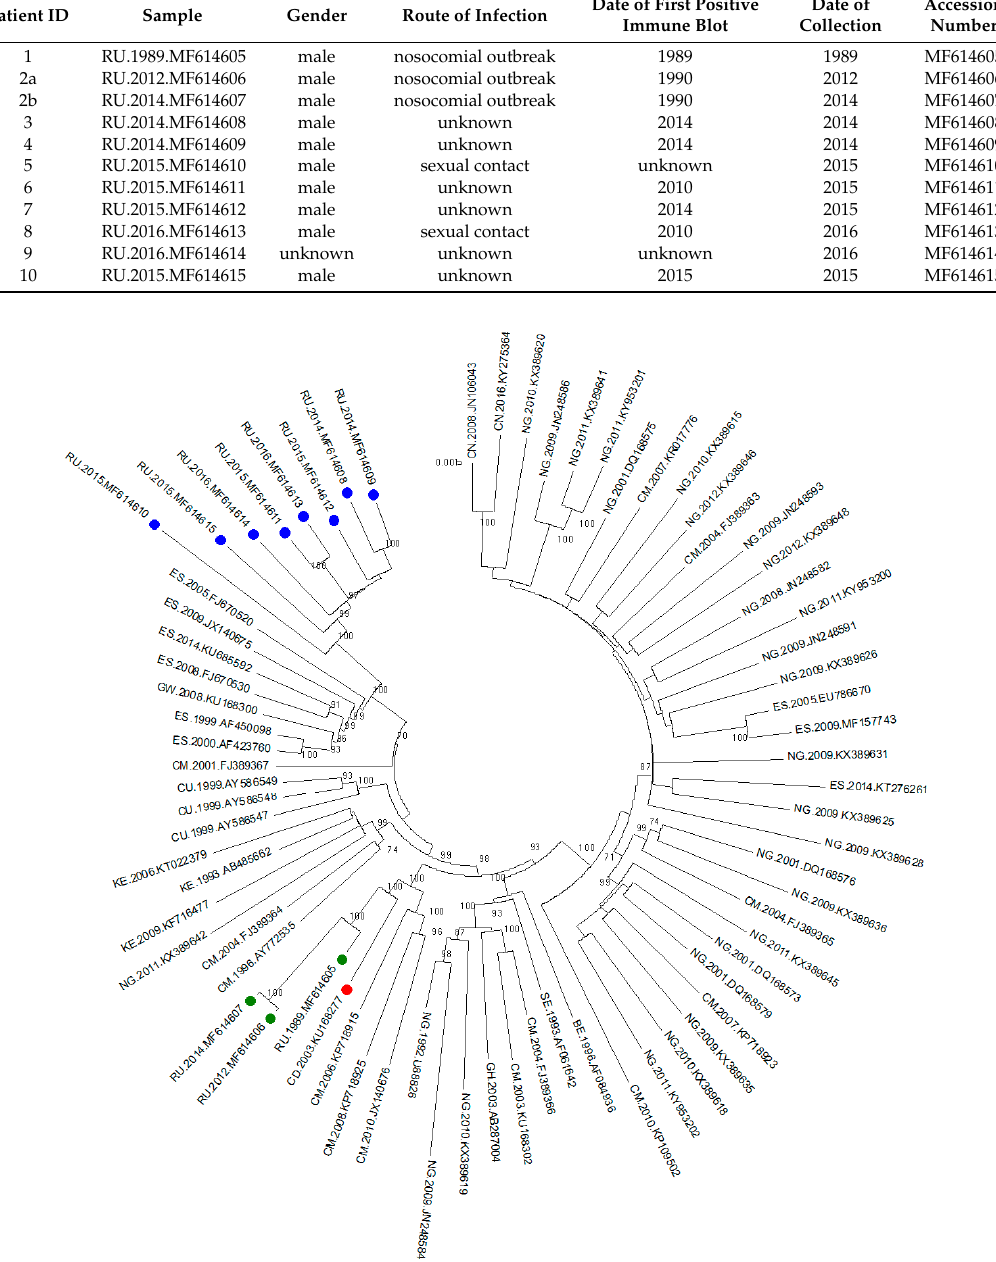
Table 1. Characteristics of the Russian patients for whom near full-length genome sequences were obtained.